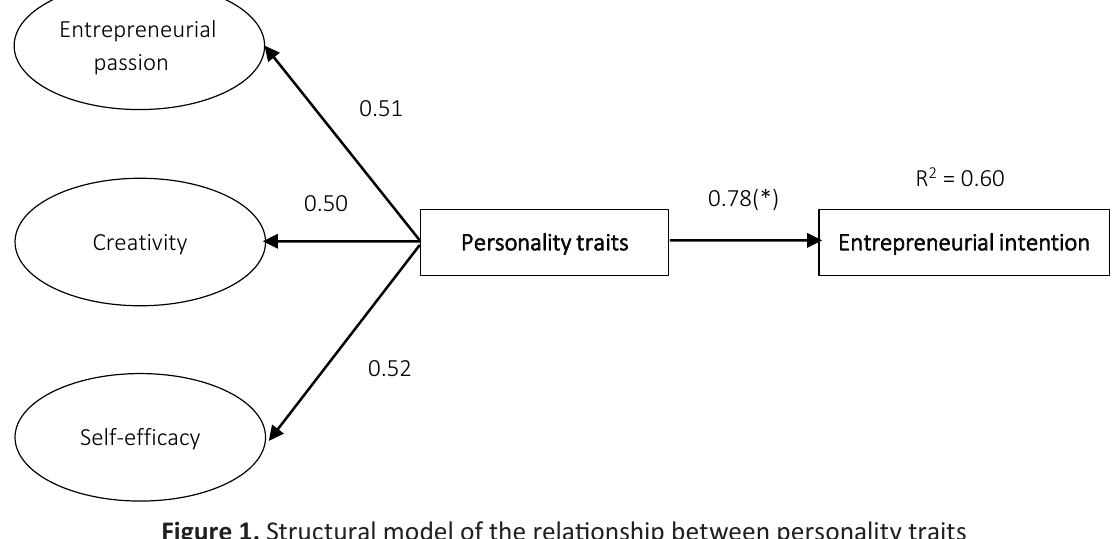
Figure 1. Structural model of the relationship between personality traits and entrepreneurial intention